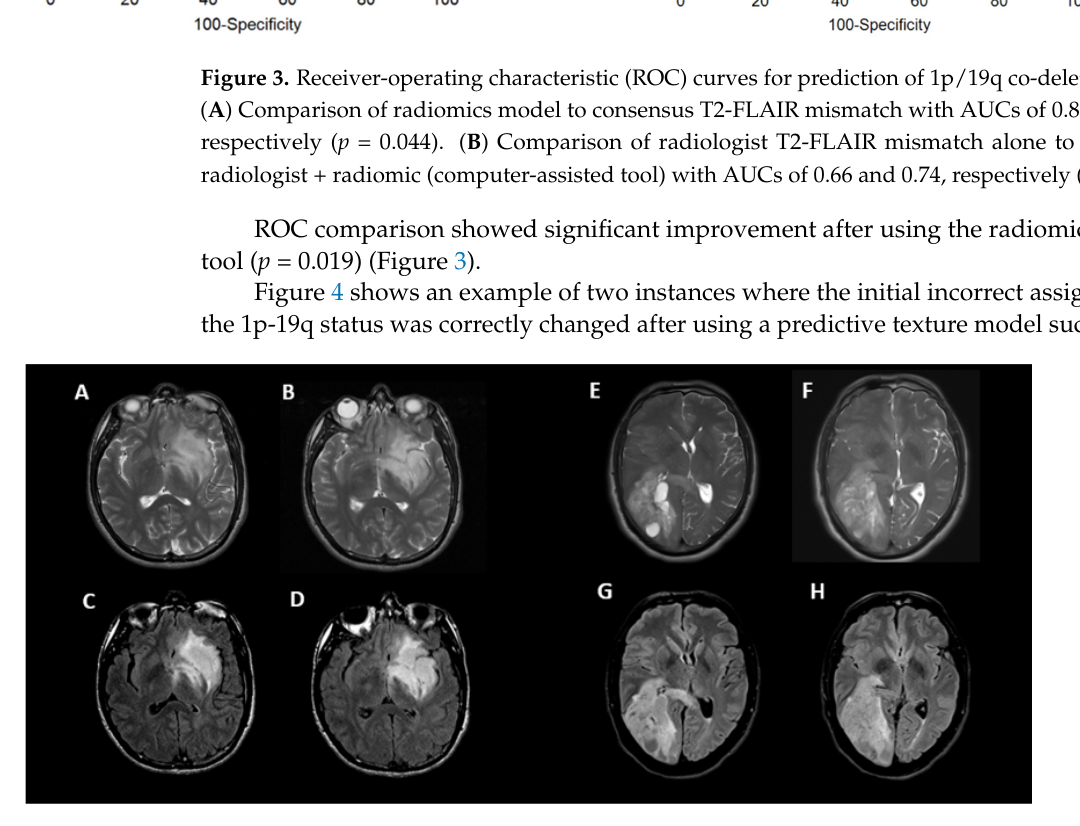
Figure 4. Two examples of correct changes made to T2 ‐ FLAIR mismatch evaluation with